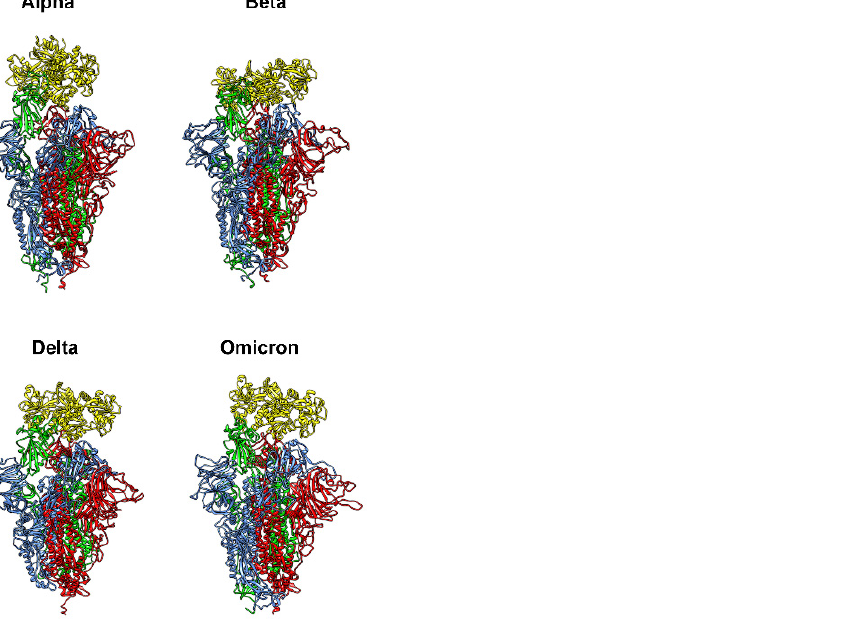
Figure 10. Complex between bovine lactoferrin (bLf) and the four Spike variants of interest obtained through molecular docking simulations. bLf is represented with yellow ribbons, while the three different chains composing the Spike glycoprotein are represented by red, blue, and green ribbons.